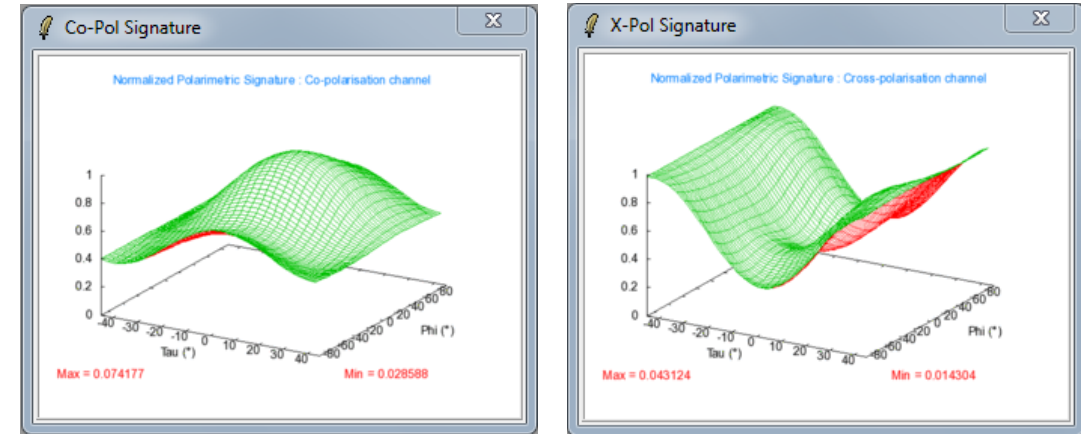
Figure 7. (c) Tonalite polarimetric